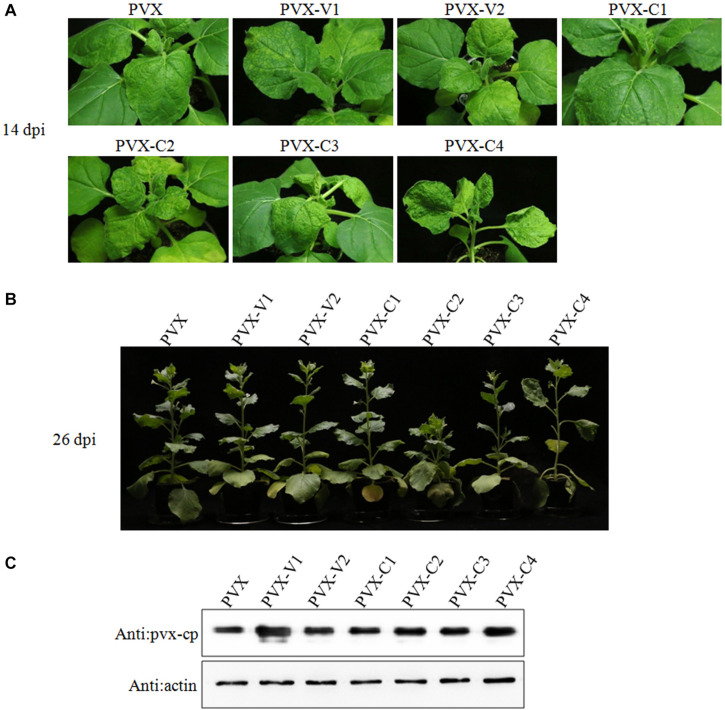
Transient expression of individual GGVA genes from potato virus X (PVX)-based vectors after infiltration of N. benthamiana plants. (A,B) Symptoms produced in N. benthamiana plants agroinfiltrated with PVX-based vector harboring GGVA-encoded proteins (V1, V2, C1, C2, C3, and C4), respectively. Plants were photographed at 14 dpi or 26 dpi. (C) The CP protein of PVX detected by western blotting using a polyclonal antibody against PVX CP. Actin, which is stably expressed in plants, was used as the internal reference.